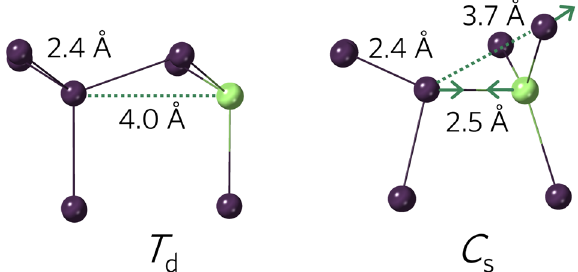
Fig. 5 Cation-anion rebonding undergone by As (cid:1) 2 the left is the metastable T d structure identi fi ed by standard defect relaxation, and to the right the ground state C s symmetry identi fi ed by our method. Ga in green and As in purple.